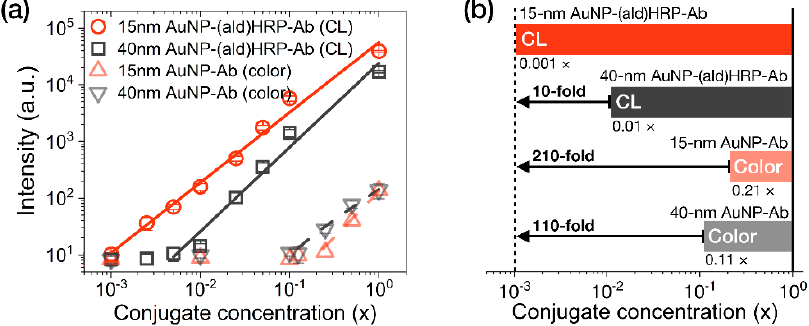
Figure 4. Evaluation of the analytical sensitivity of AuNP conjugates on LFA test strips. ( a ) Intensity plot showing the colorimetric responses of AuNP-Ab conjugates and the CL responses of AuNP- (ald)HRP-Ab conjugates (red line, R 2 = 0.989; black line, R 2 = 0.978; gray dashed line, R 2 = 0.988; red dashed line, R 2 = 0.954). ( b ) Comparison of the analytical limits of detection (LoDs) of each AuNP conjugate. The numbers labeled below each bar indicate the LoD of the respective conjugates. All conjugates were physically immobilized to the nitrocellulose (NC) membrane through spotting and drying. All data shown in ( a ) represent the mean ± SD (n = 3).